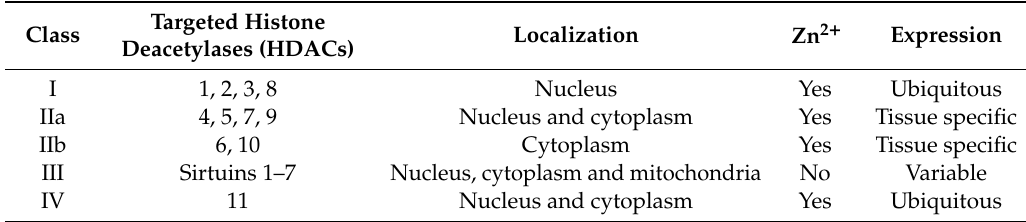
Table 1. Classification of histone deacetylase